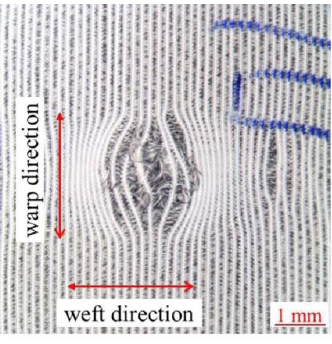
Figure 8. Bursting stress of elastic knits as related to parameters of different functional yarns. The error bar indicates the SD.